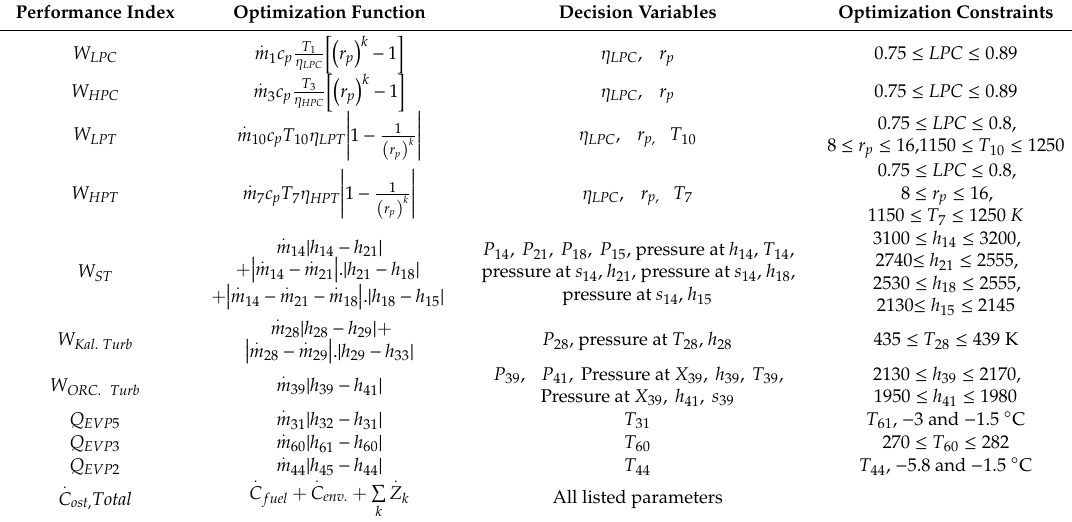
Table 13. Components of optimization functions and